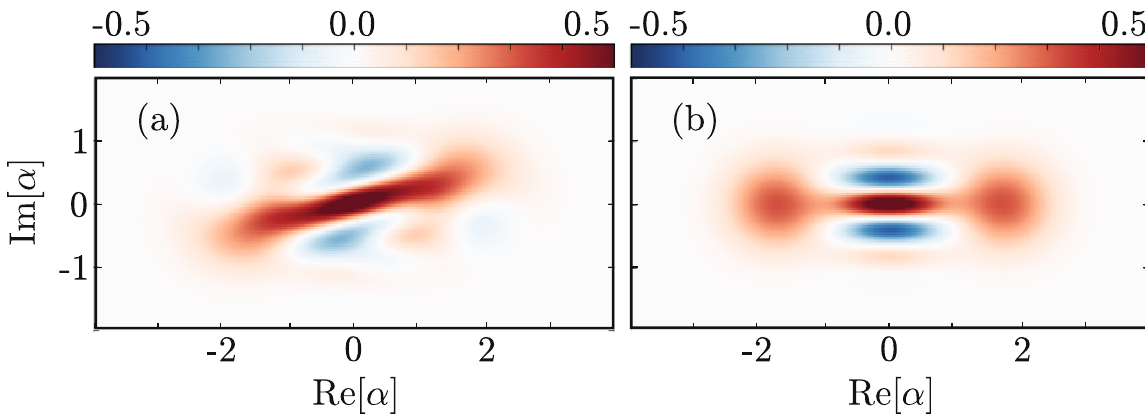
Fig. 2 Wigner function for a KNR initialized in vacuum | 0 〉 and driven by a a single parametric drive E p ¼ E 0 orthogonal parametric drives, E p ¼ E 0 plotted at time t = 1.37 τ , with τ = 1/ K , E 0 cat state. However, the auxiliary drive induces counter-adiabatic terms, resulting in near perfect initialization of the cat state. At t = 1.3 τ , the fi delity with respect to C